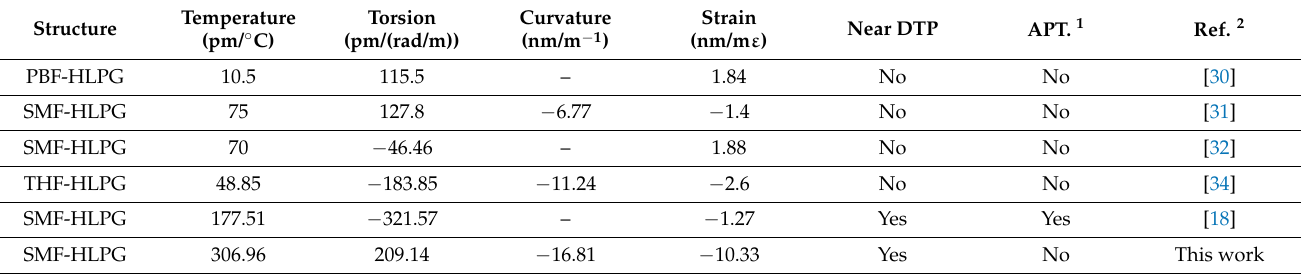
Table 1. Comparison of the dual-resonance SMF-HLPG with different